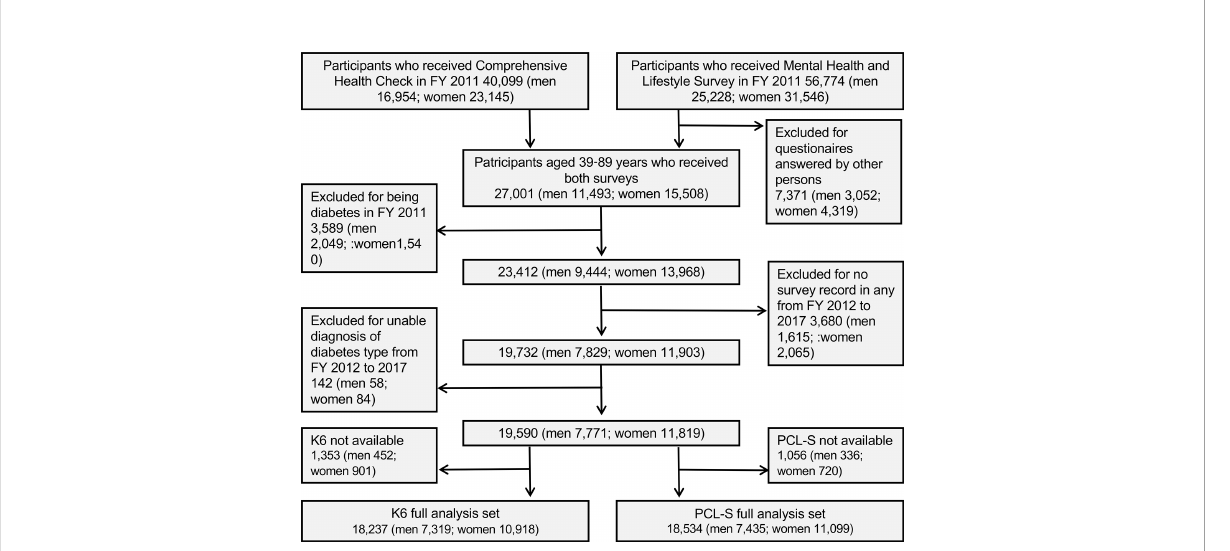
FIGURE 1 Enrollment fl owchart of studied participants in Fukushima Health Management Survey. FY: fi scal year; K6: Kessler 6, PCL-S: PTSD Checklist Stressor-Speci fi c